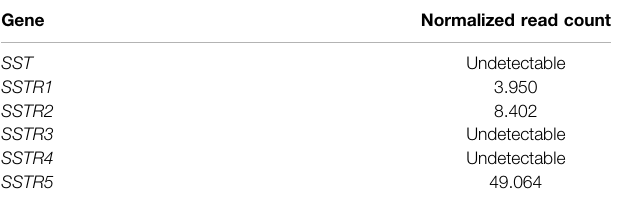
Frontiers in Pharmacology |